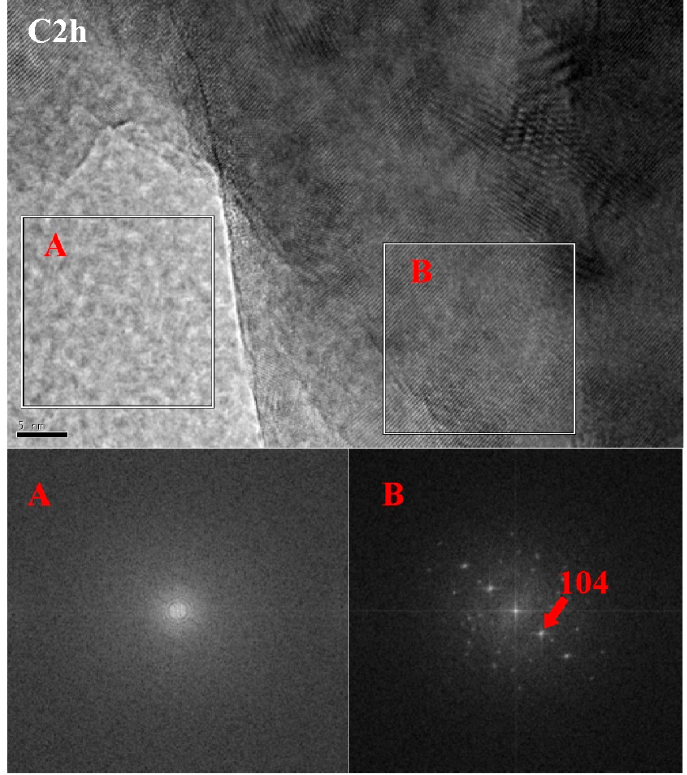
Figure 12. High-resolution TEM (HRTEM) image and selected area Fourier transform images of C2h.